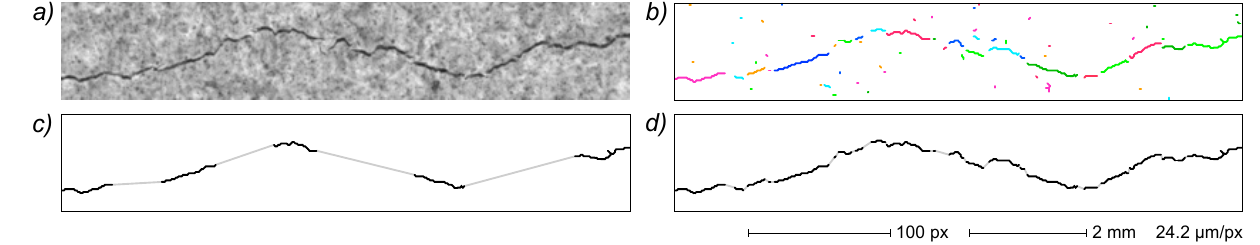
Figure 8. Small subgraph recovery. Image of a small crack ( a ) generates a primal EG ( b ) that is processed up to the subgraph merging step ( c ), where several parts were filtered out during noise removal and replaced by distal edges. The recovering algorithm retrieves the missing small subgraphs from primal EG and inserts them in the merged subgraph ( d ). Distal edges are depicted in gray.